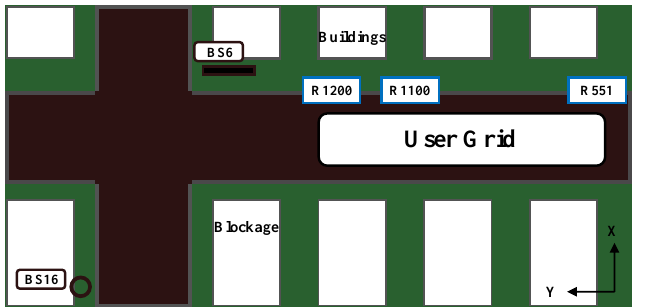
Figure 4. This figure represents a part of the O1 scenario. The sixth base station (BS6) is acting as an IRS to reflect the signal from a transmitter to a receiver. BS16 is a transmitter and also a receiver, as is every user device in the User Grid from row 551 (R551) to row 1200 (R1200). Every row contains 181 user devices. The building across the road from BS16 is acting as a